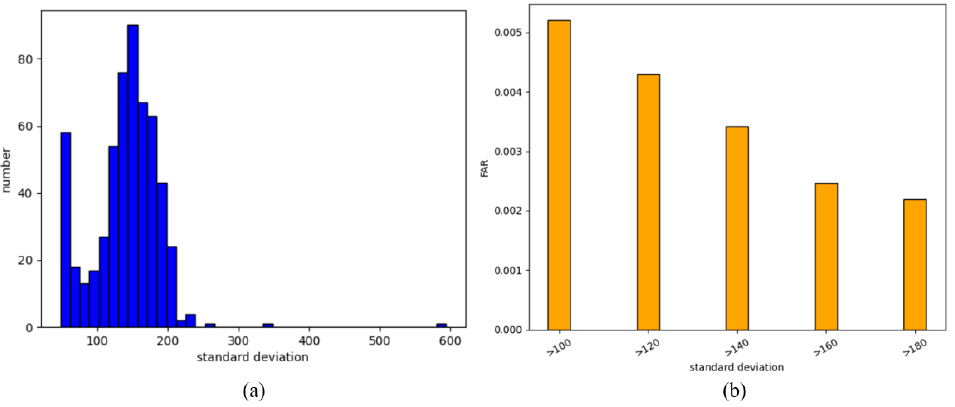
Figure 4. ( a ) Histogram of the standard deviation of the data. ( b ) FAR of different data with a standard deviation greater than σ (cid:48)